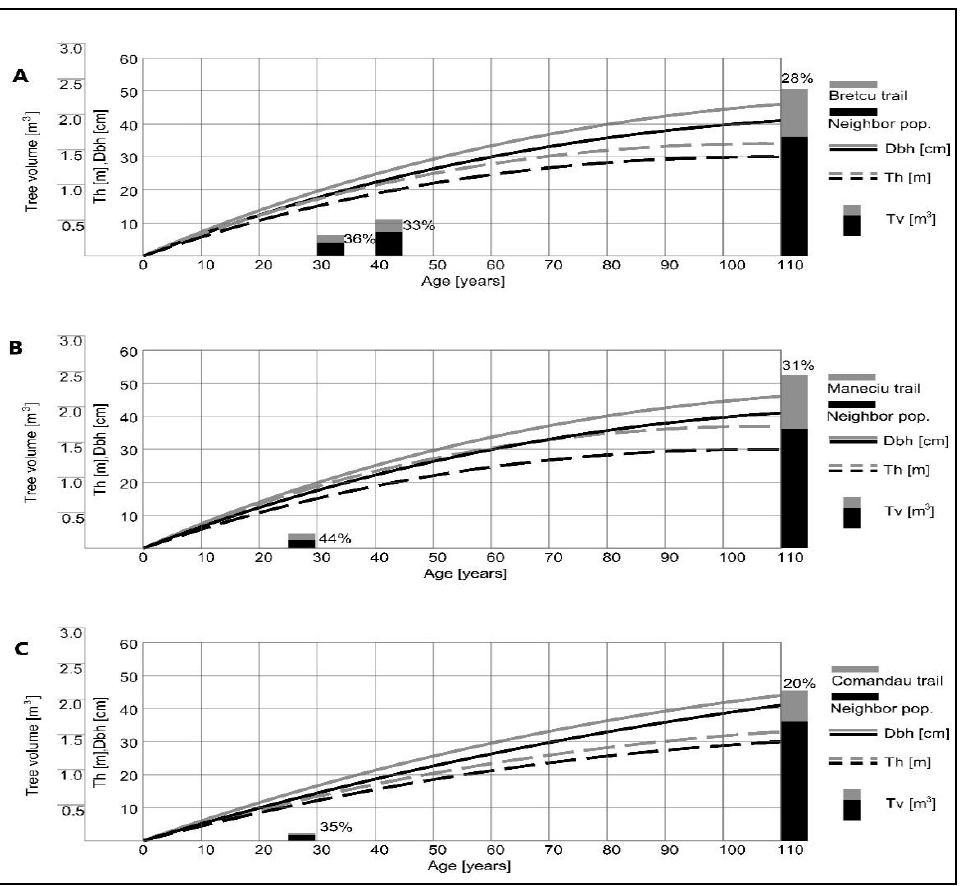
Figure 4. Prediction of the growth model development until the end of the rotation period for Brețcu ( A ), Măneciu ( B ) and Comandău ( C ) trials, compared to their unimproved neighboring populations. ( A ), M ă neciu ( B ) and Comand ă u ( C ) trials, compared to their unimproved neighboring